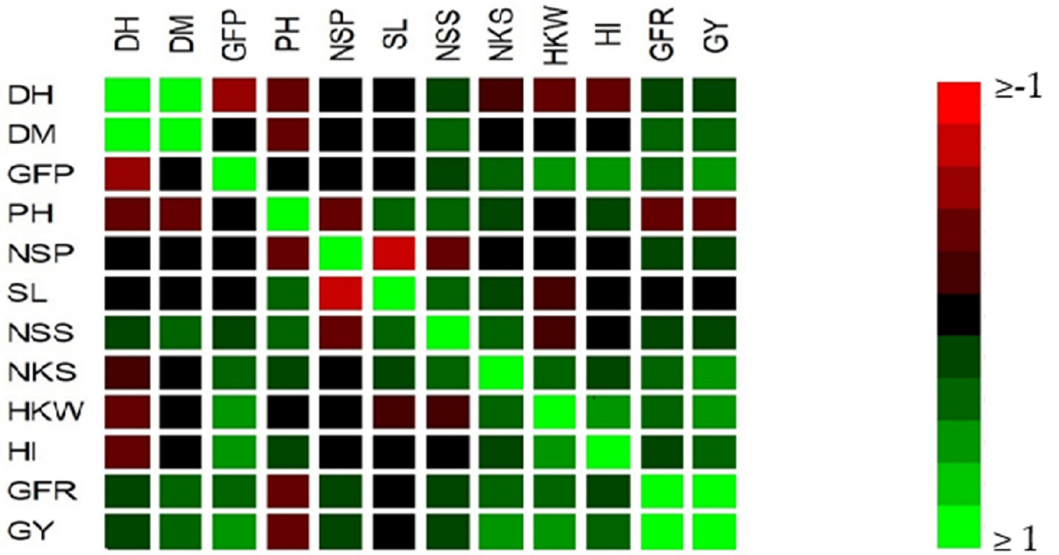
Fig 3. Correlation matrix between the 12 measured traits of wheat genotypes for combined data (n = 34). Days to heading (DH, days), days to maturity (DM, days), grain filling duration (GFD, days), plant height (PH, cm), number of spikes (NS, m 2 ), spike length (SL, cm), number of spikelets per spike (NSS), number of kernels per spike (NKS), hundred kernel weight (HKW, g), harvest index (HI, %), grain yield (GY, ton ha -1 ), and grain filling rate (GFR, %).